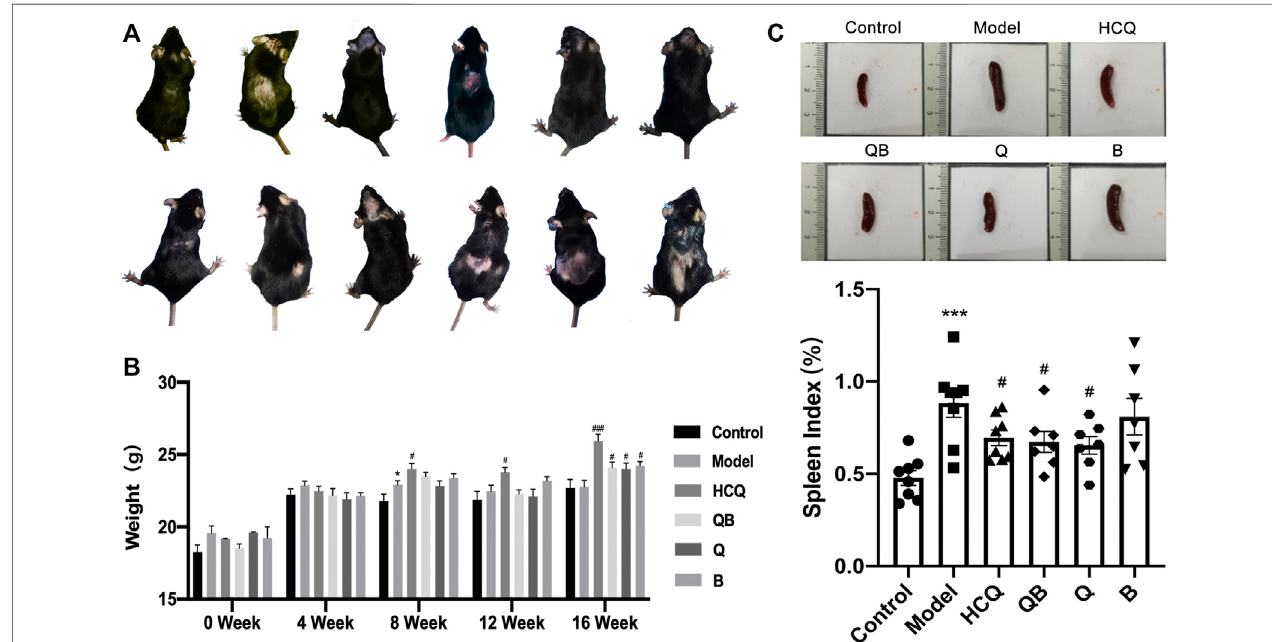
FIGURE 1 | General characteristics in systemic lupus erythematosus (SLE) combined with atherosclerosis mice. (A) Hair condition of experimental mice. (B) The body weight of mice. (C) The spleen volume and spleen index ofmice. The data are expressed asthe mean ± SEM. Model group compared withthe controlgroup, * p < 0.05, *** p < 0.001; the remaining groups compared with the model group, # p < 0.05, ### p <